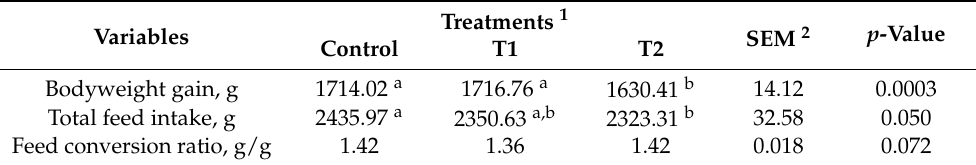
Table 4. Effect of Tribulus Terrestris (TT) supplementation on growth performance in broiler chickens from 1 to 35 days of age.